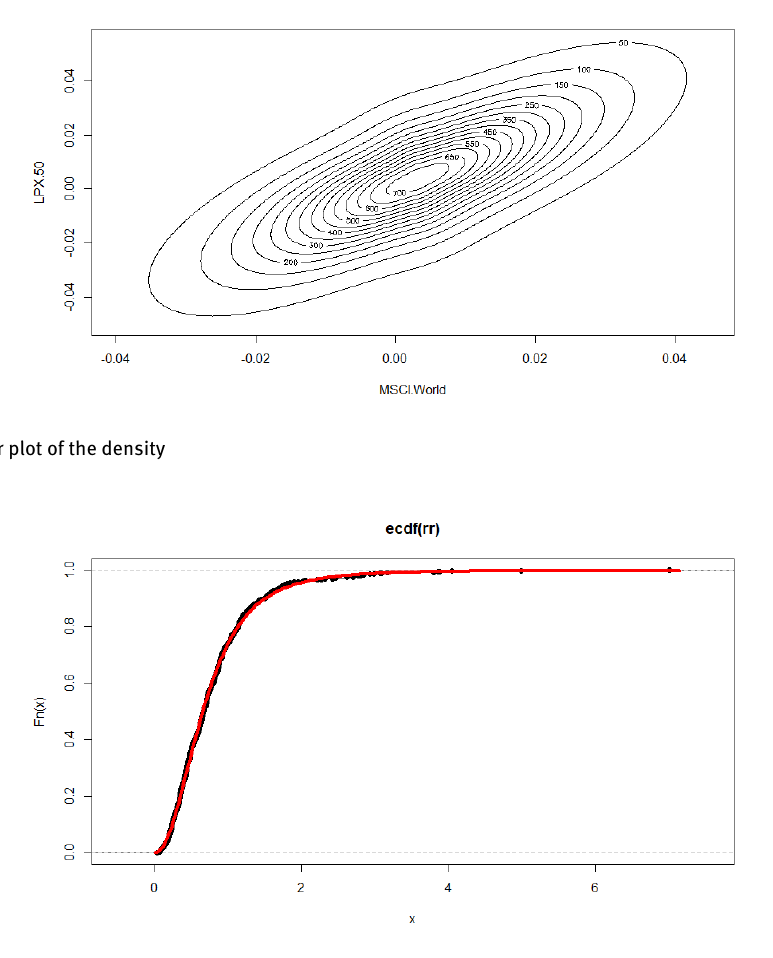
Figure 13: empirical distribution function of R (black) and that of the model (red).